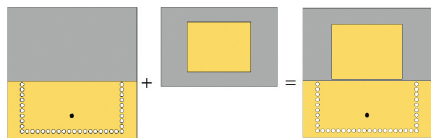
Figure 1: Construction of the proposed antenna element.